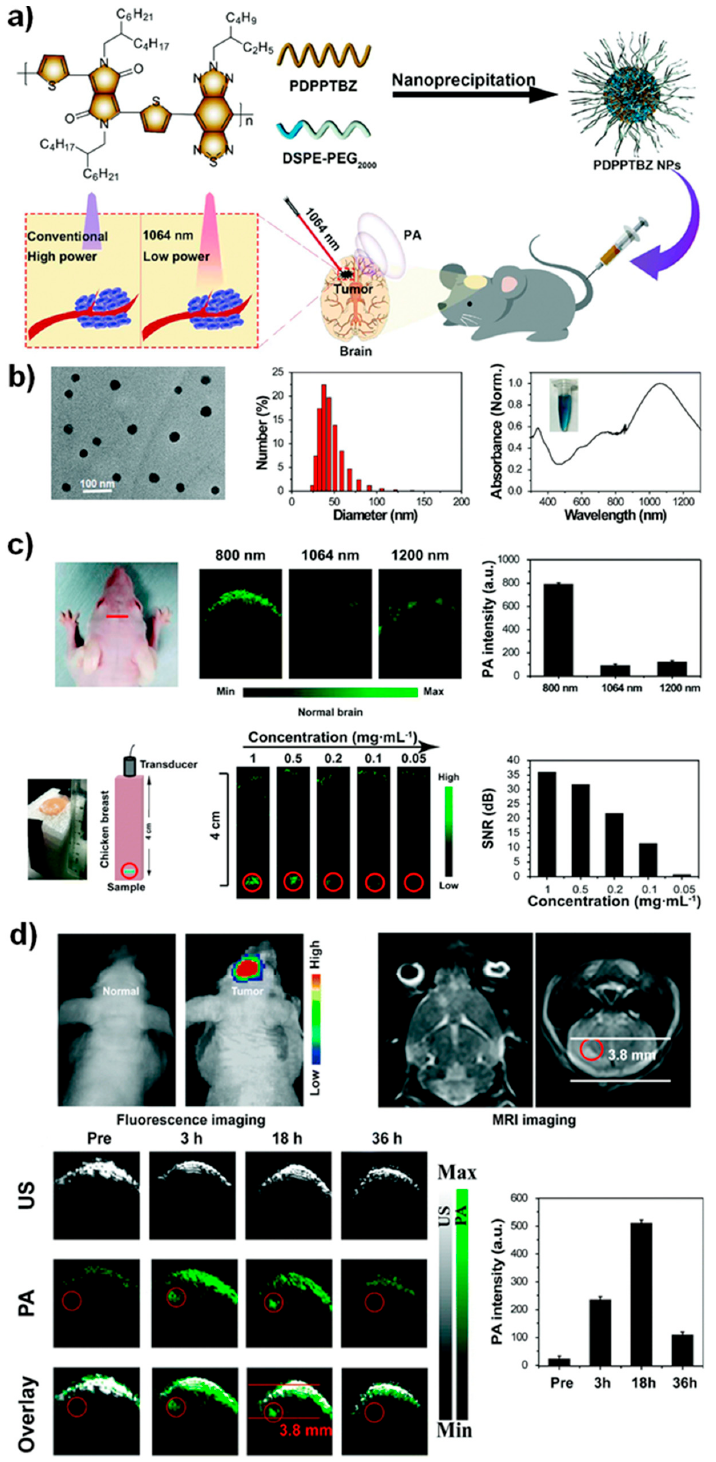
Figure 6. ( a ). Scheme with representative images shows the functional polymer associated PAI nanomaterials. ( b ) TEM morphology, size, and absorption (UV) features, ( c ) PAI scanning of the mice brain under the pulsed field lasers and corresponding quantification analysis, and ( d ) bioluminescence, MRI, and PA imaging conditions of the mice brain shows the ultrasound and PA signals produced by the nanoparticles with grey and green color, respectively. Reprinted with permission from Ref. [124]. Copyright 2021 Royal Society of